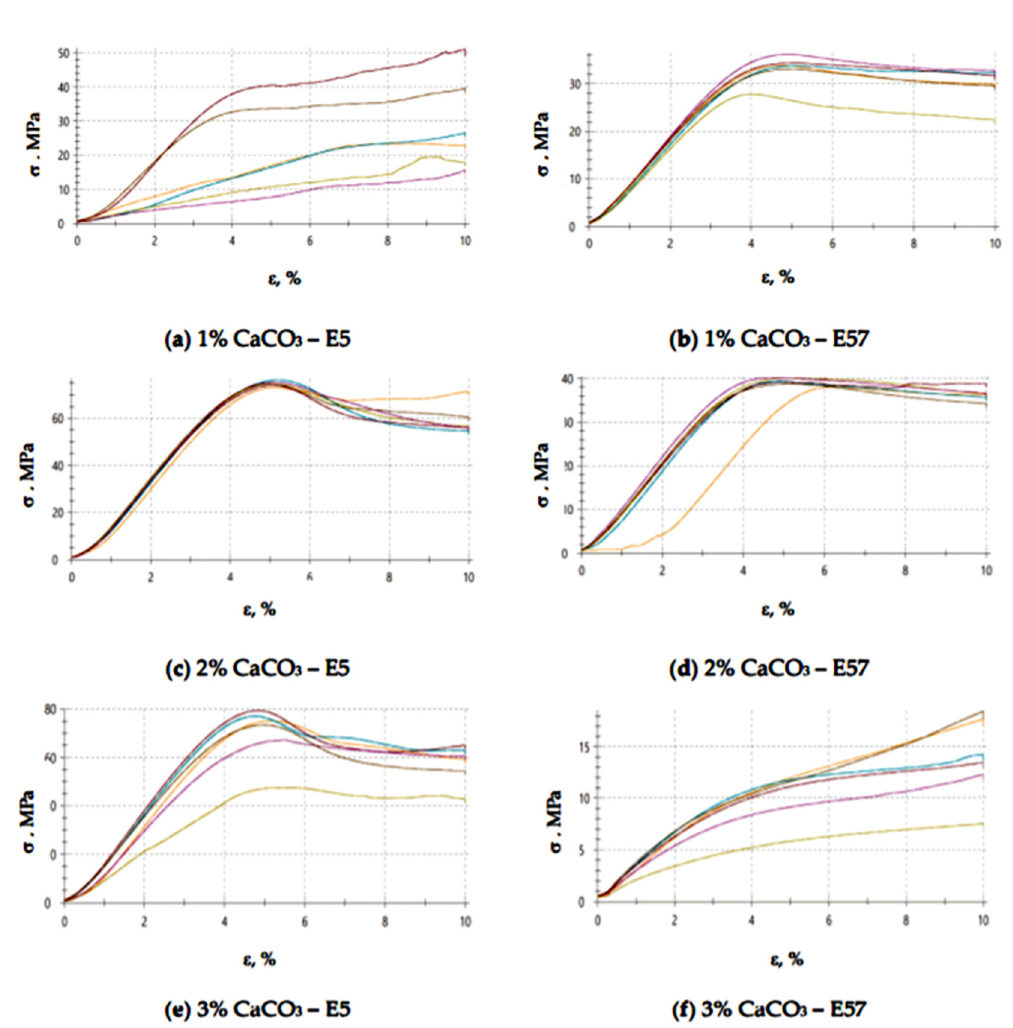
Figure 6. Stress–strain curves of the E5 / PAC / 100:80 and E57 / PAC / 100:80 epoxy specimens modified by the calcium carbonate filler: ( a ) 1% CaCO 3 —E5, ( b ) 1% CaCO 3 —E57, ( c ) 2% CaCO 3 —E5, ( d ) 2% CaCO 3 —E57, ( e ) 3% CaCO 3 —E5, ( f ) 3% CaCO 3